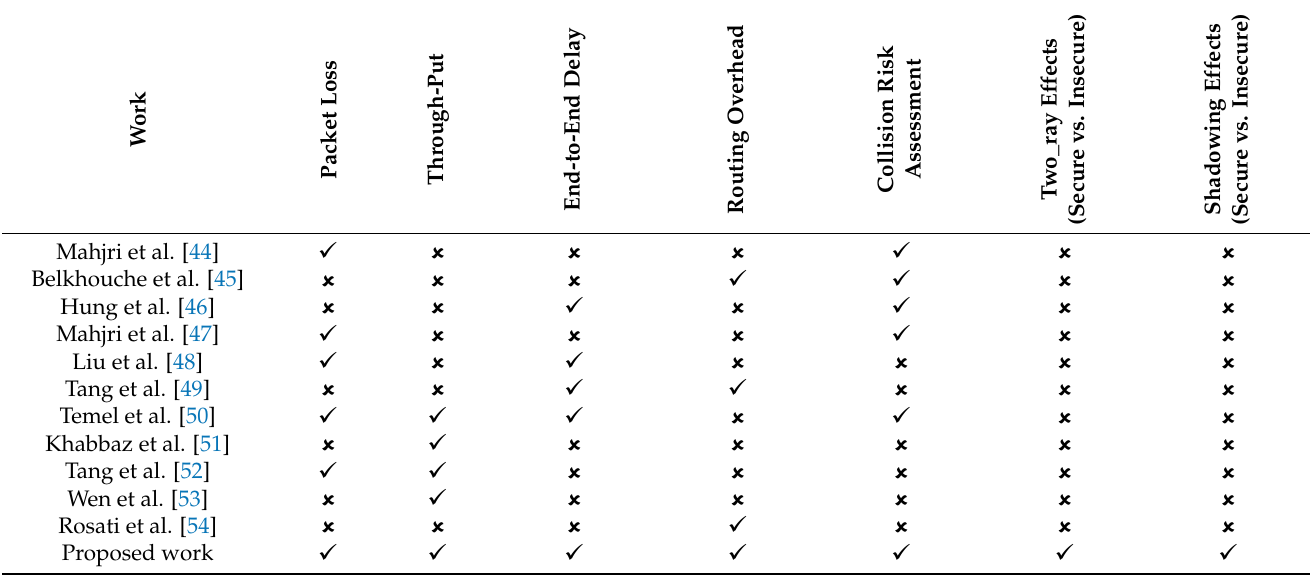
Table 2. Characteristics of flying ad-hoc network.